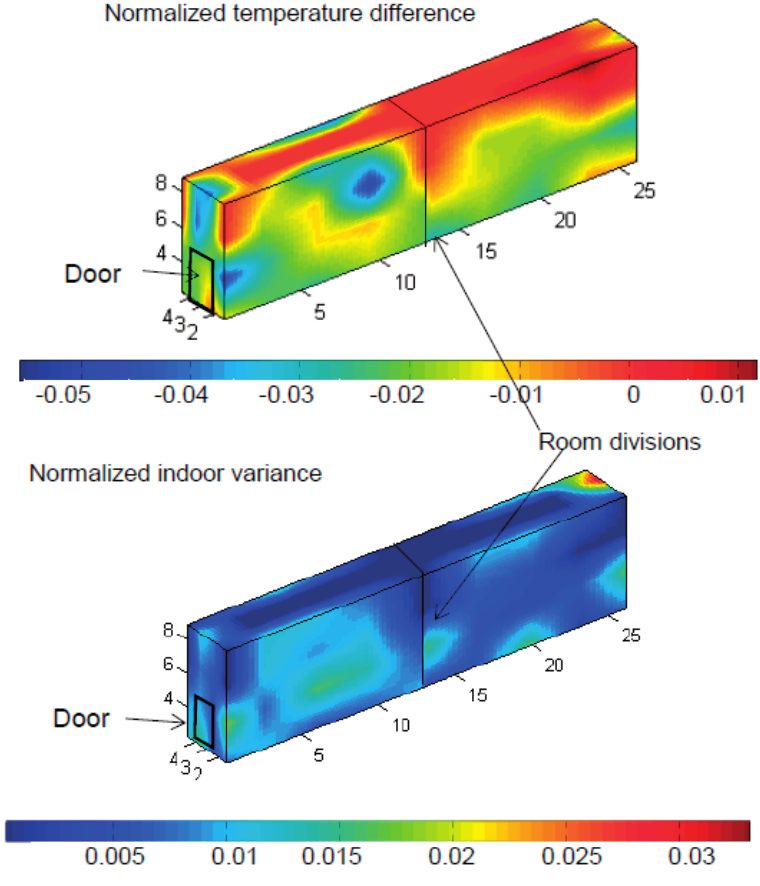
Figure 3. 3D plot of Normalized Temperature Difference and Indoor Variance in Chamber